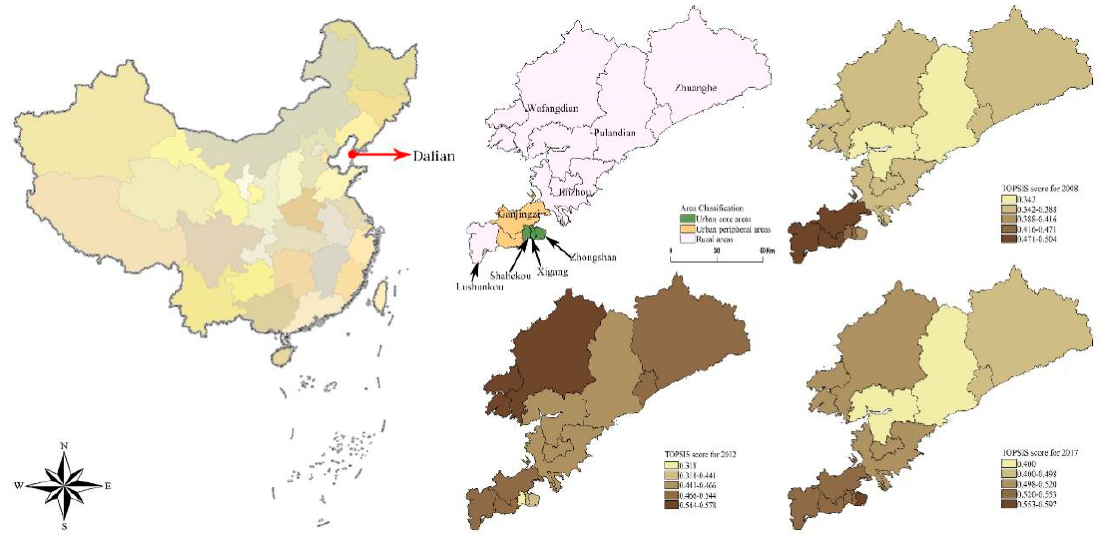
Figure 2. 2008–2017 Dalian City, urban and rural medical TOPSIS score change. In the urbanized part of the city, Ganjingzi District had the highest score at 0.498 in 2008. But its score began to decrease after 2009, while the scores in the other urban areas continued to rise from 2010. The highest score in rural areas in 2008 was Lushunkou District (0.491), while the lowest was Jinzhou District (0.420). By 2017, Zhongshan District replaced Ganjingzi District as having the highest regional average score (0.584) among the urban areas. Lushunkou District (0.527) remained the highest score among the rural districts, while the Pulandian District became the worst-scoring area (0.391). The average scores for Zhuanghe City (0.507) and Jinzhou District (0.471) increased significantly from 2008 to 2012. 3.2. Indicator Contribution The indicator contribution scores were calculated for each region, and the summary is presented in Table 1. For analysis, we selected the top four indicators for each region (see Table 4) and highlighted the indicators that had at least 5% contributions. For urban core areas, per capita disposable income (C6, 8.56–8.63%), regional GDP (C9, 7.78–8.54%), government healthcare expenditure (C10, 7.12–8.2%), and house prices (C7, 5.91–7.04%), are the top four indicators (where C6 > C9 > C10 > C7). For peripheral urban areas (Ganjingzi), number of medical institutions (C12, 10.29%), per capita disposable income (C6, 9.83%), government health care expenditure (C10, 9.09%), and regional GDP (C9, 8.71%) were the top four indicators (where C12 > C6 > C10 > C9). For the rural areas, the top four indicators were number of medical institutions (C12, 10.68–2.08%), per capita disposable income (C6, 10.50–10.85%), government health care expenditure (C10, 9.01–9.22%), and regional GDP (C9, 8.06–8.60%), similar to the ranking in the urban peripheral region (where C12 > C6 > C10 > C9). The results indicate that increasing per capita disposable income in the urban core region is the most effective way of achieving healthcare improvements, while in the urban fringe and rural areas, building more medical institutions is the most efficient means to improve the healthcare system. We calculated the cumulative frequency of the second criterion layer (B1–B7) for each region and visualized them in a histogram (Figure 3A). For both urban and rural areas, population pressure (B1, 21–32.1%) and cost of living (B2, 15.1–22.3%) are the major obstacles to healthcare service. For urban core areas, population pressure (B1, 21–25.9%), cost of living (B2, 17.2–22.3%), and resident medical insurance (B7, 14.4–17.5%) are the main impediments. For the rural areas, four indicators presented the most obvious impact healthcare development: population pressure (B1, 23.1–31.6%), cost of living (B2, 15.1–19.4%), medical infrastructure (B5, 13.7–15.8%), and residential health care (B7, 11.6–16.2%).